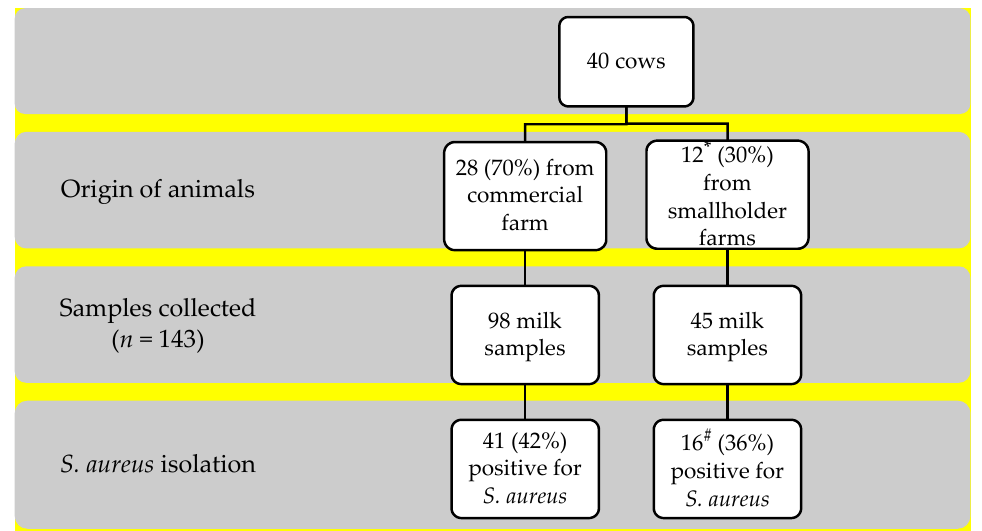
Figure 1. Samples collected and frequency of Staphylococcus aureus isolation. * Average of two cows/smallholder farm. # In one sample two S. aureus isolates with distinct phenotypes were found.